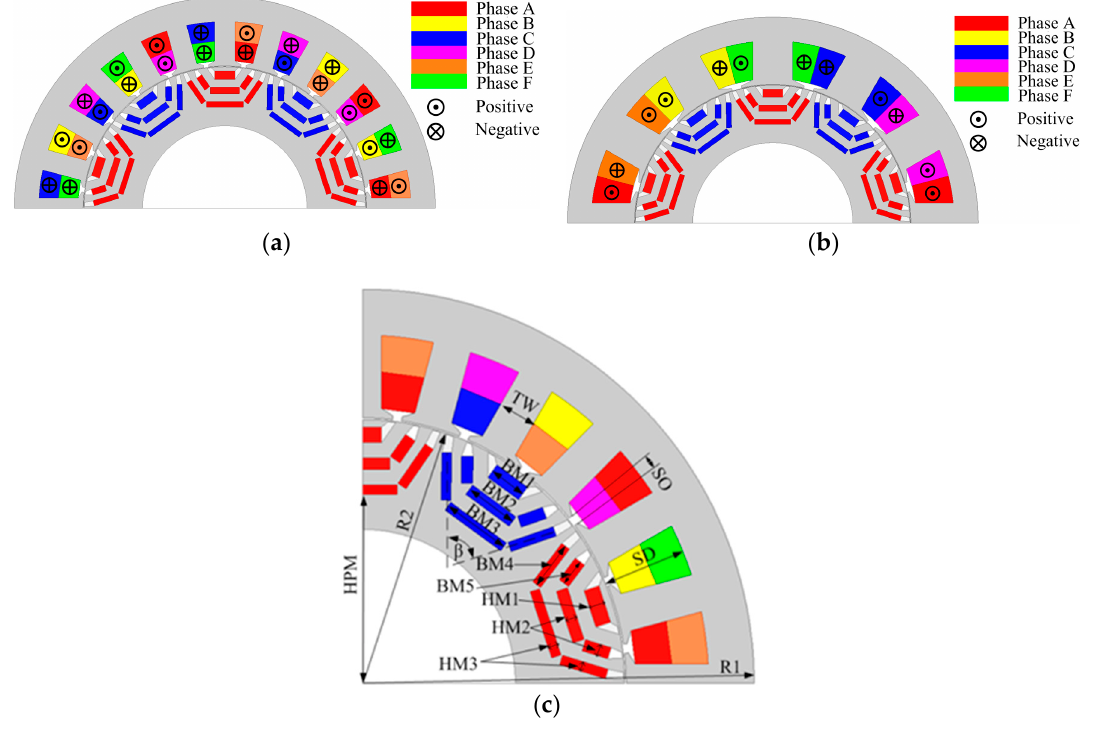
Figure 6. Permanent-magnet-assisted synchronous reluctance machines (PMA-SynRMs) with different winding layouts: ( a ) 24-slot/10-pole layout (Design A); ( b ) 12-slot/10-pole layout (Design B); ( c ) The geometrical parameters.